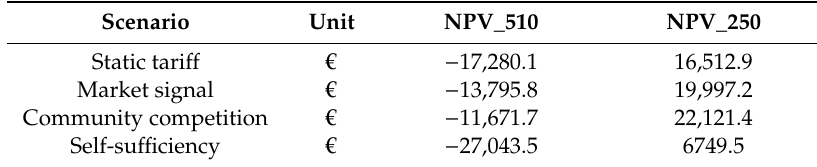
Table 8. NPV for different aggregation scenarios 1 . Table 8. NPV for di ff erent aggregation scenarios 1 .